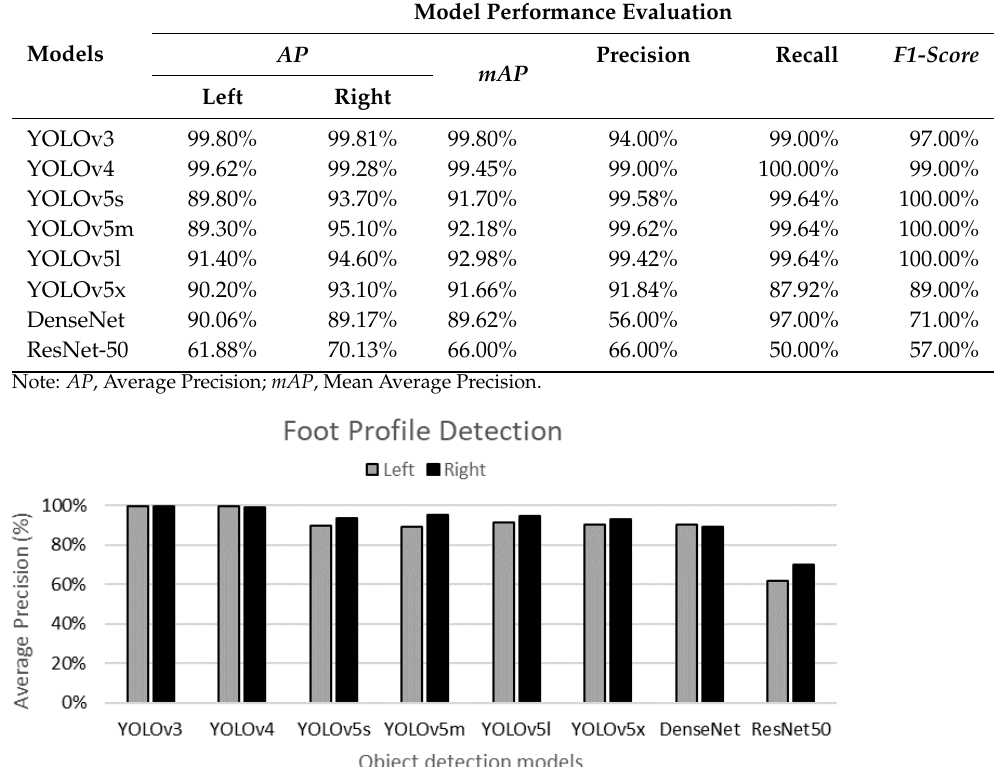
Figure 5. The average precision of left and right foot detection in different object detection models. The average AP on different object detection models was 89.01% and 91.86% on the left foot and right foot, respectively. The average AP on YOLO models was 93.35% on the left foot and 95.93% on the right foot. The right foot showed higher accuracy than the left foot in average AP in all YOLO series, as well as DenseNet and ResNet-50 models. Fur- thermore, in the YOLOv3 model, the highest AP was 99.80% and 99.81% on the left foot